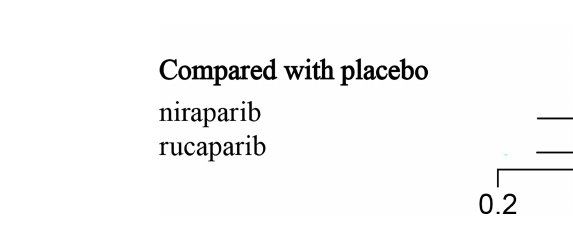
The data in bold are statistically signi fi cant.